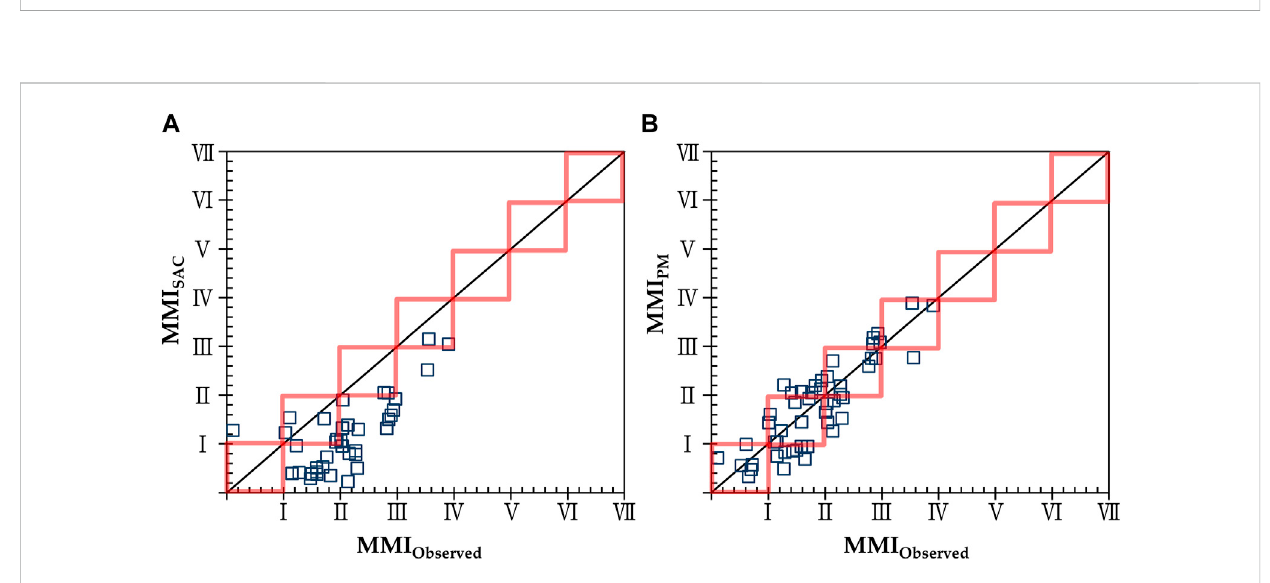
Veri fi cation of both models. (A) Applied SAC (B) applied the proposed model.